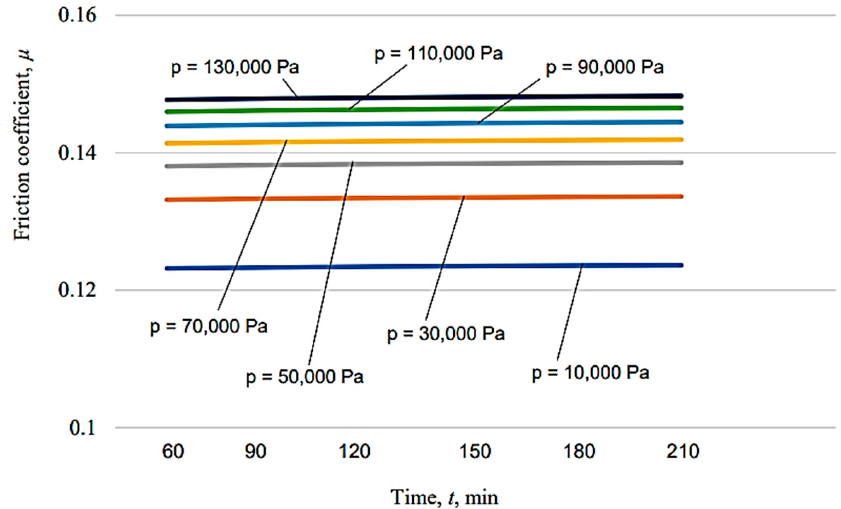
Figure 16. Influence exerted by the process duration t on the friction coefficient µ for different pressures p in the case of vibroburnishing applied to the tested surface.